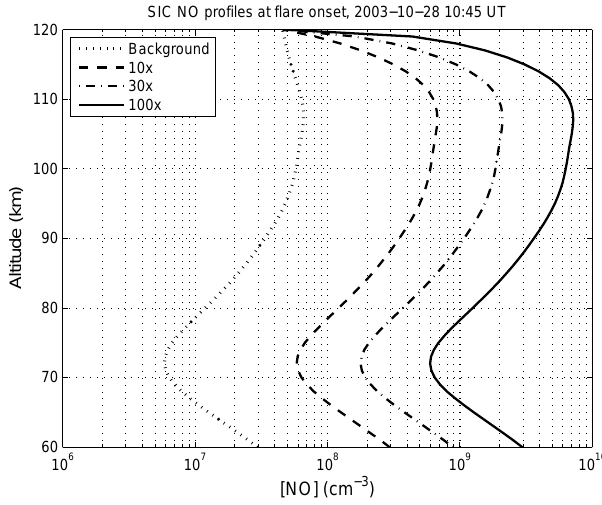
Fig. 3. SIC model NO concentration profiles at the onset of the X17 flare of 28 October 2003, 10:45UT. The initial profile was scaled by constant factors of 10, 30 and 100 at start of run (08:00 UT); thereafter the profiles change slowly by chemical